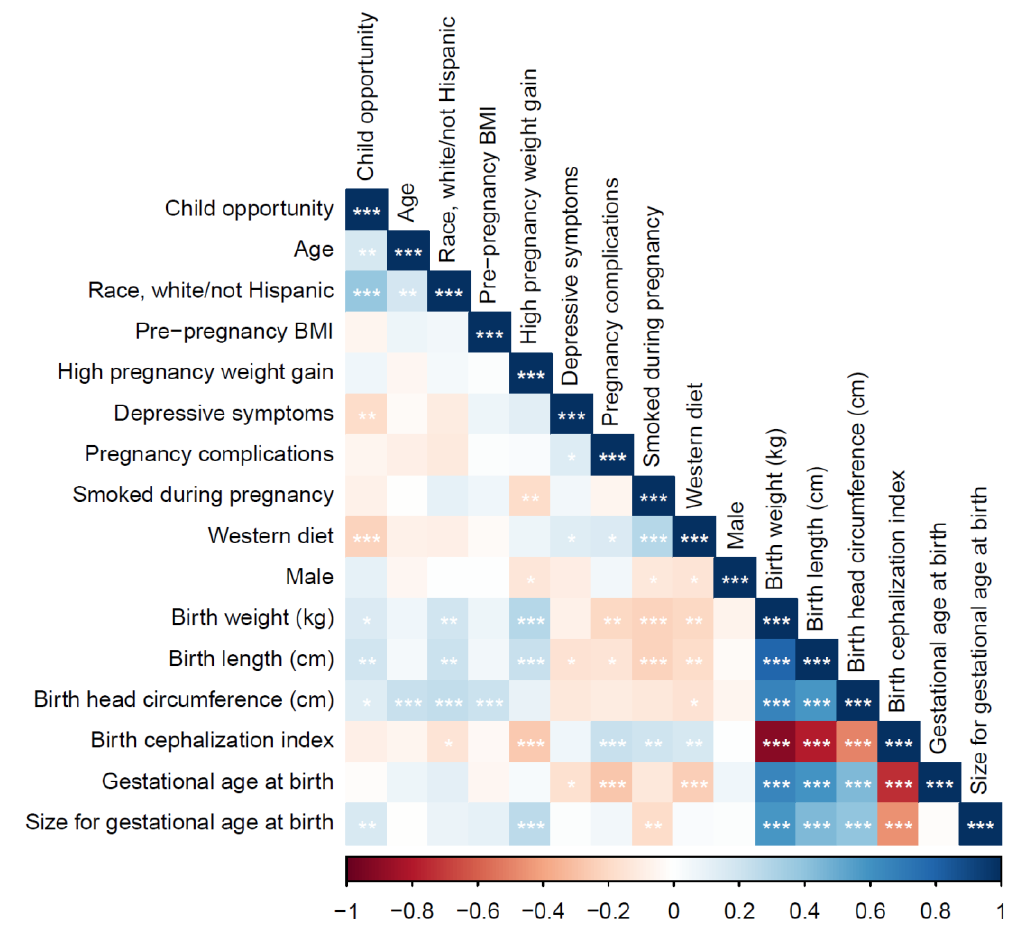
Figure 2. Correlations among study variables. Table 3. Adjusted associations between neighborhood level child opportunity and maternal health during